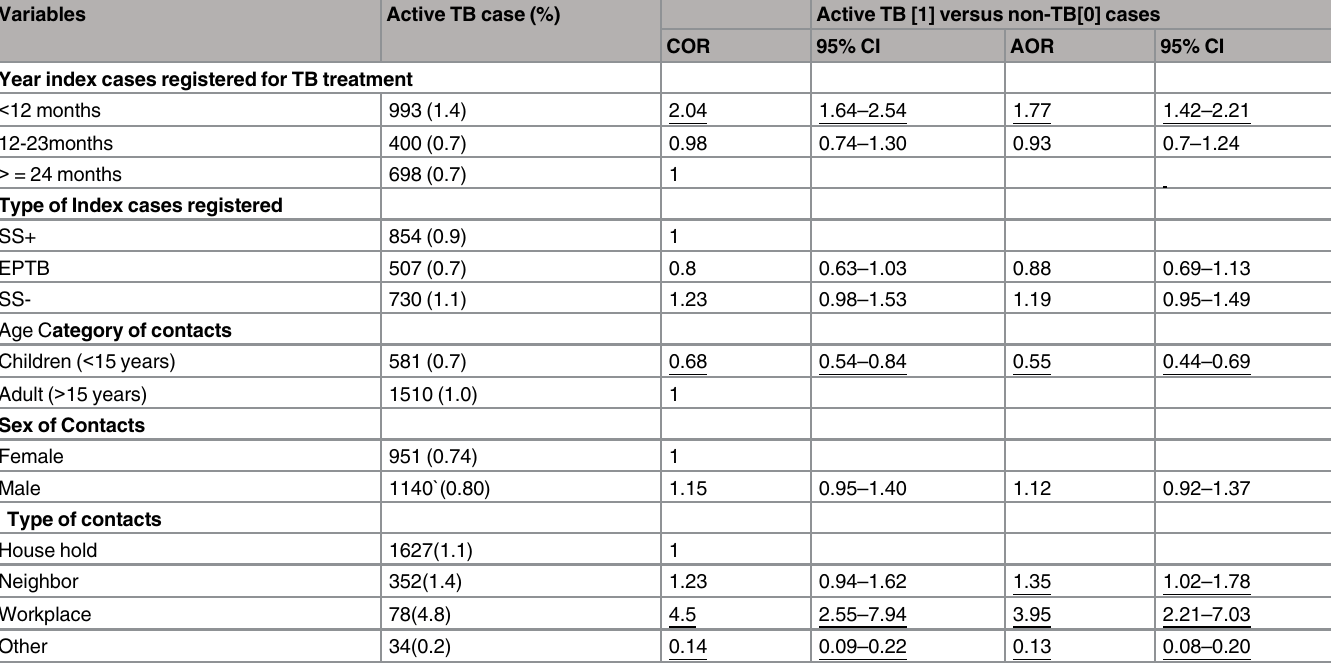
Table 2. Factors associated with active TB in retrospective contact investigation, June – October 2014 Ethiopia.